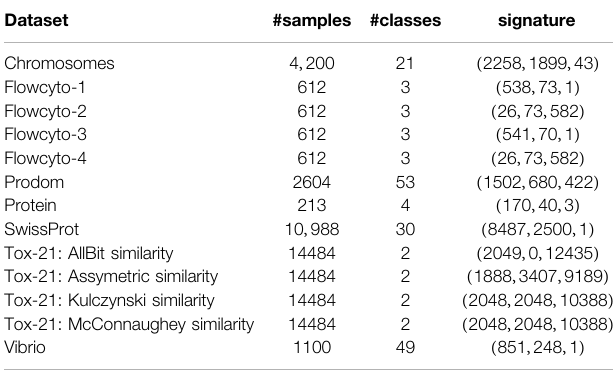
TABLE 2 | Overview of the different datasets. Details are given in the textual